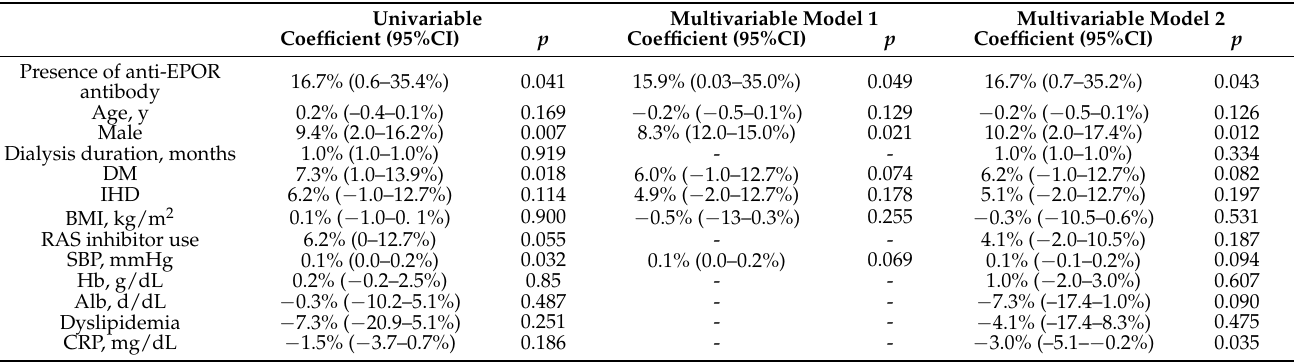
Univariable and multivariable linear regression analysis for logarithmically trans- formed